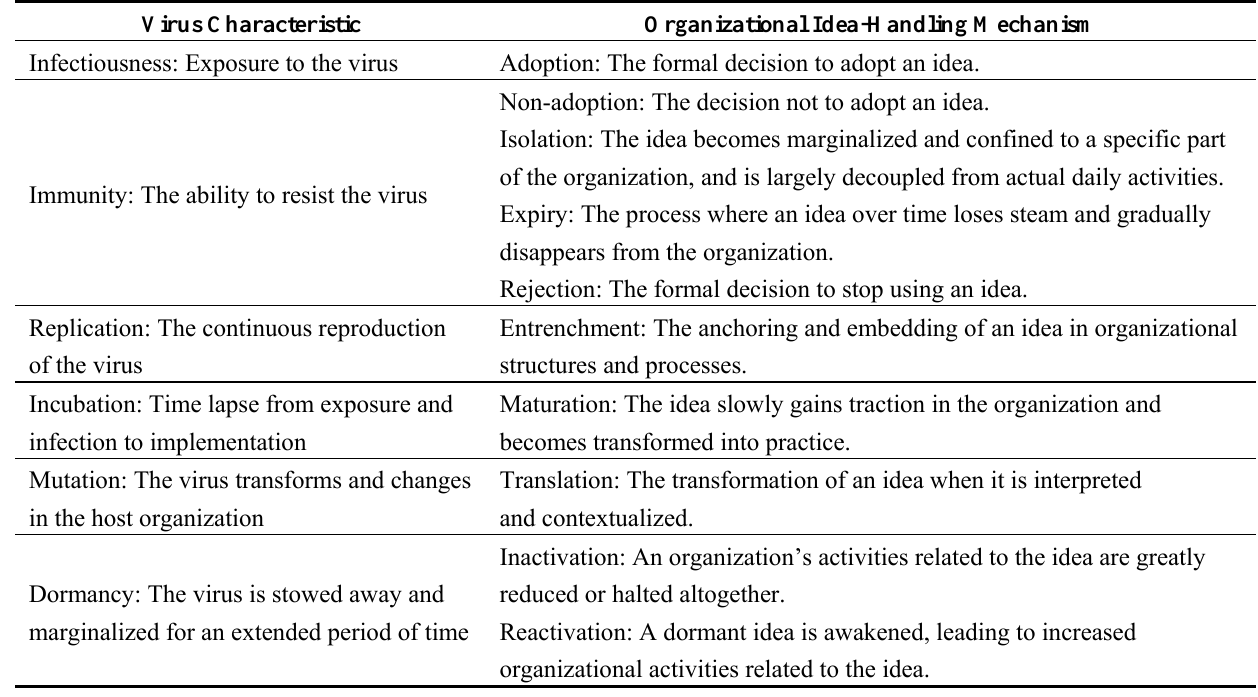
Table 1. Virus characteristics and idea-handling mechanisms (adapted from: [39] (p. 646)). Virus Characteristic Organizational Idea-Handling